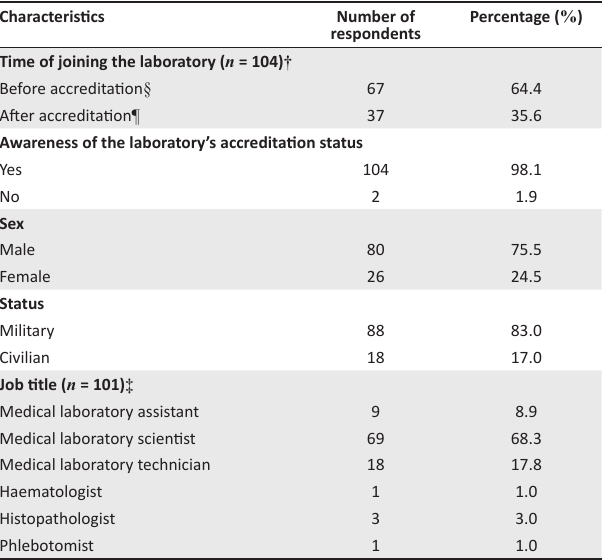
TABLE 1: Characteristics of study respondents ( N = 106) at the Pathology Division Laboratory, 37 Military Hospital, Accra, Ghana, November 2020. Characteristics